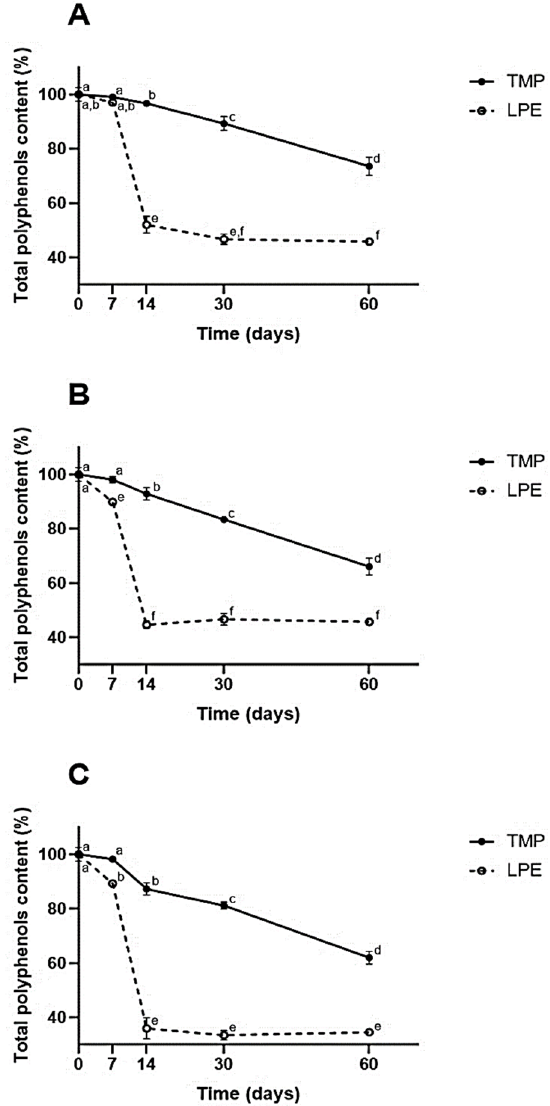
Figure 2. Total polyphenol content of samples submitted to different temperatures over 60 days. TMP = taperebá peel microparticles with chitosan; lyophilized peel extract (LPE). ( A ) Refrigerated temperature ~2–6 °C. ( B ) Room temperature ~25 °C. ( C ) Heat stress temperature ~40 °C. Different letters in each graph represent statistically significant differences ( p ≤ 0.05) according to the Tukey HSD test.